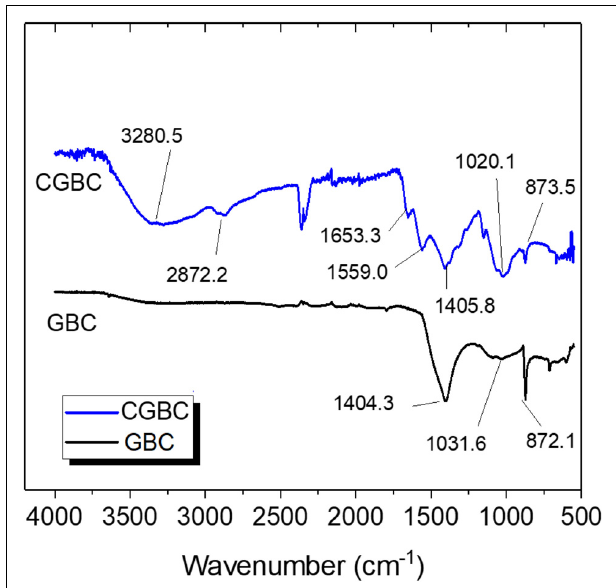
FIGURE 1 | FTIR spectra of CGBC and